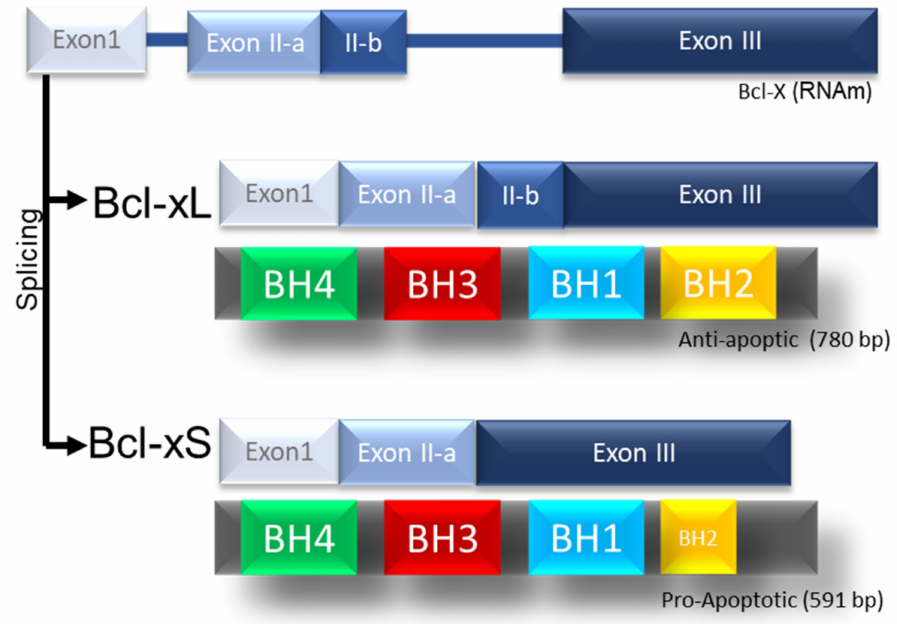
Figure 2. Scheme of the BCL-xL protein and its splicing products. Schematic representation of the splicing of BCL-2 and his products BCL-xL and